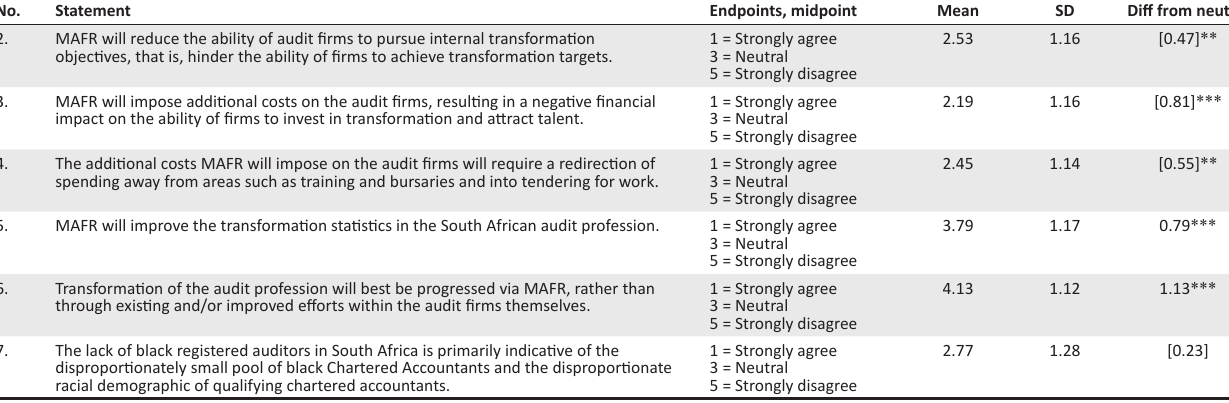
TABLE 3: Non-Big 4 audit partners’ perspectives on transformation.